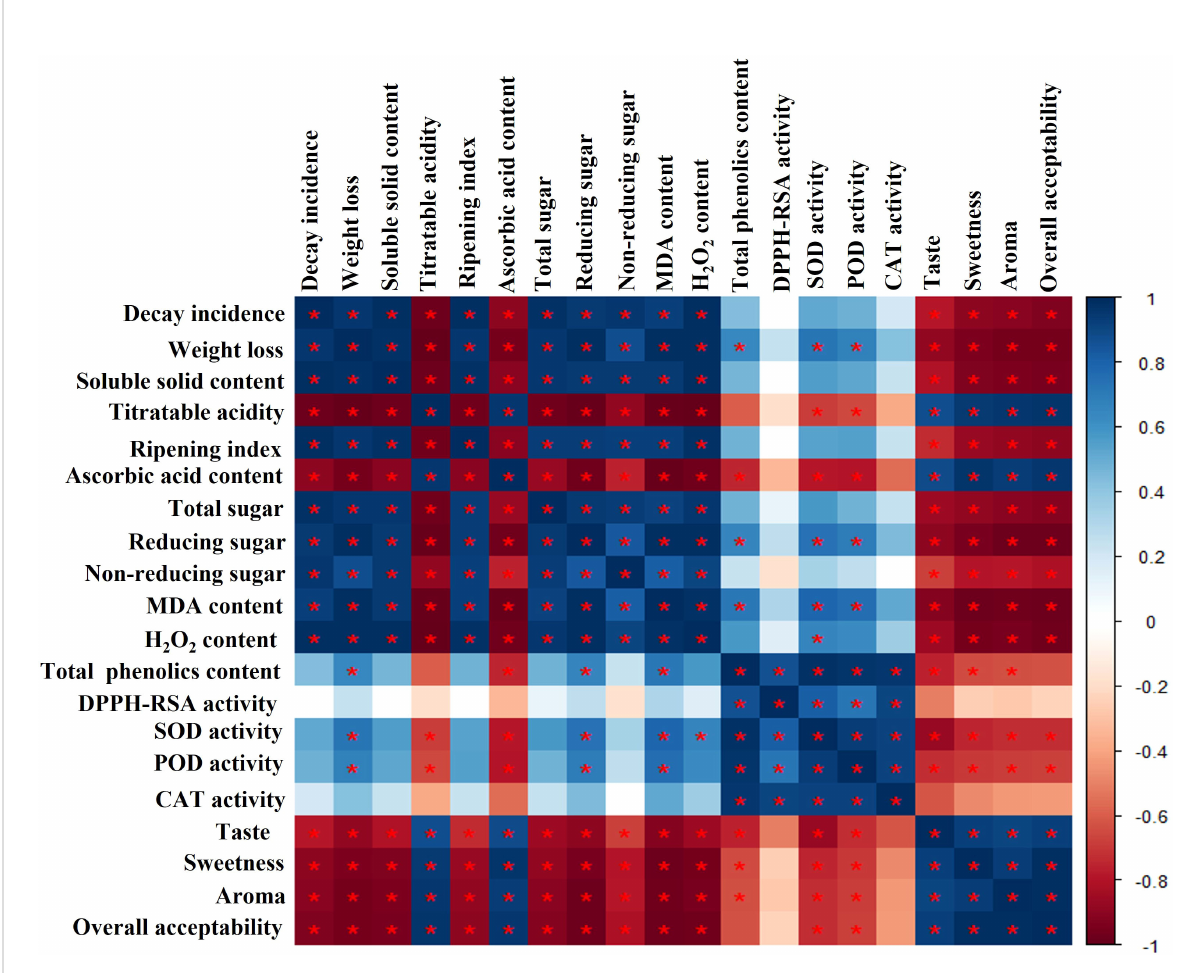
FIGURE 8 Correlation heat map analysis of each variable of EMT-treated papaya fruits during cold storage. The intensity of color represents the strength of the correlation: the blue color indicates a positive correlation, and the red color displays a negative correlation. The symbol * expresses signi fi cant